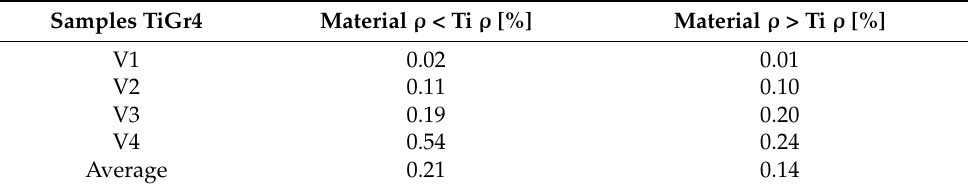
Table 4. Results of the quantitative calculation of the 3D models referring the total percentage share of material with density different than those of Ti. Analysis for spaces with a density less than that of titanium (material ρ < Ti ρ , marked in blue on the 3D models) and for a density greater than that of titanium (material ρ > Ti ρ , marked in orange on the 3D models). The applied resolution was 25 µ m (detection threshold), thus the calculation covers structural elements larger than 25 µ m only. Samples